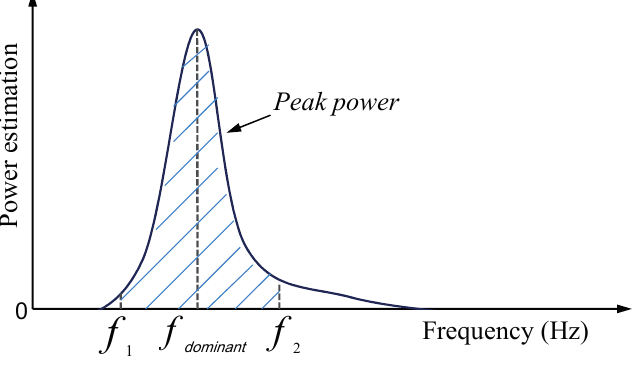
Figure 3. Power spectral density (PSD) estimation of ten-second inertial sensor